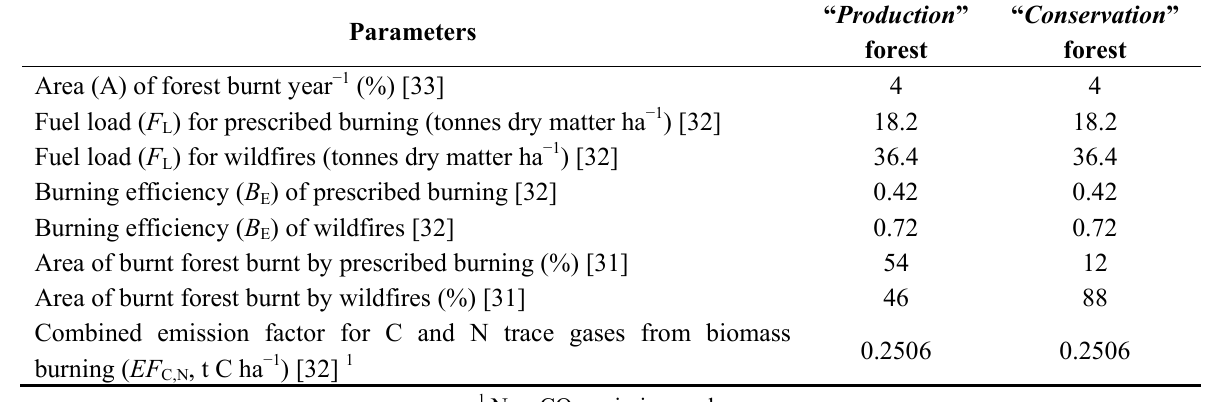
Table 3. Parameters for determining non-CO averages) from wildfire and prescribed burning for native forests in New South Wales